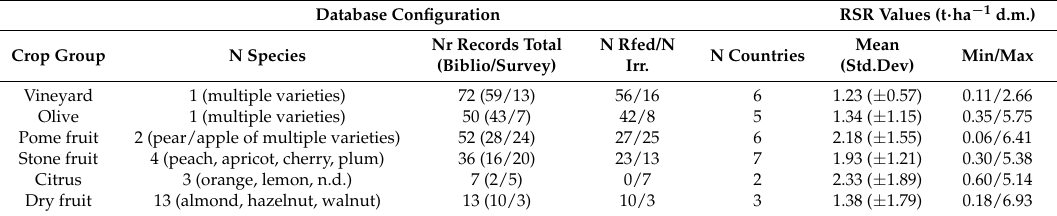
Table 2. Records contained in the database by crop, type of information source, irrigation regime and country.